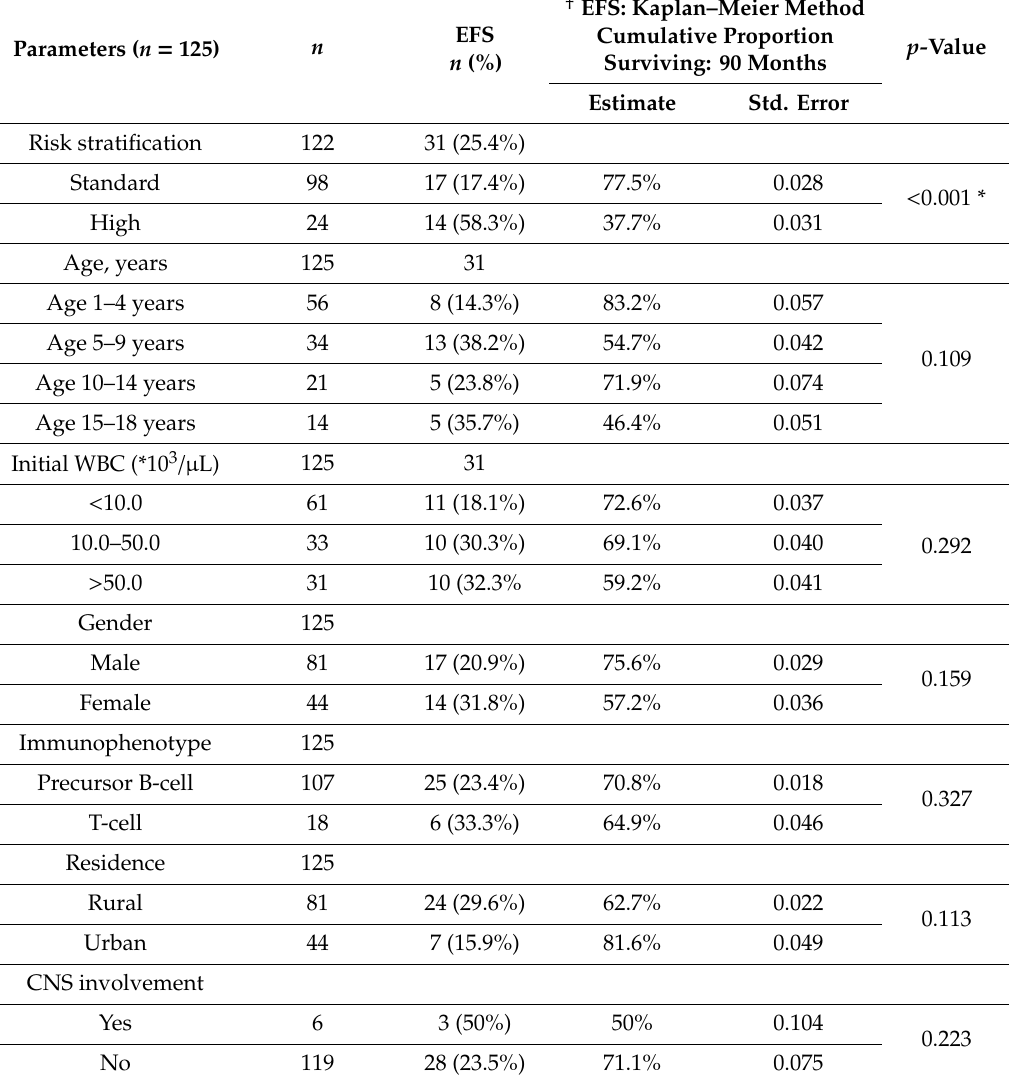
Table 6. Event-free survival (EFS) in relation to other